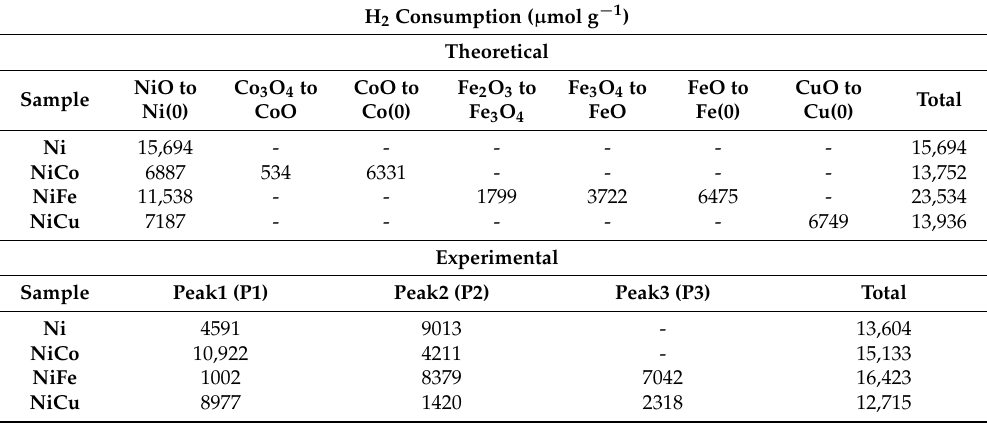
Table 1. Theoretical and experimental quantification of the amount of hydrogen consumed by the alloys in TPR